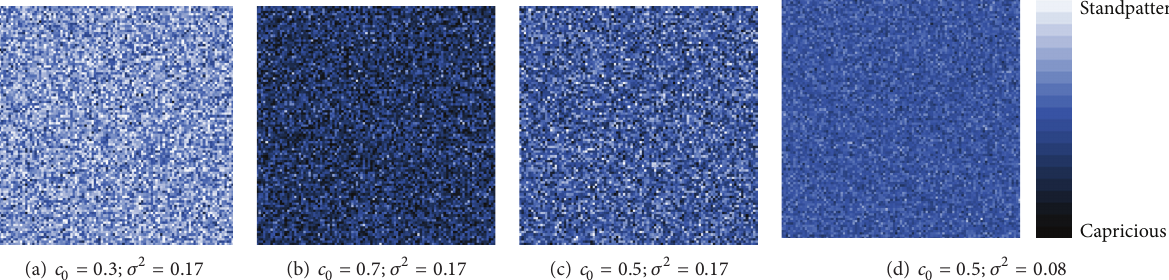
Figure 1: Influence of parameters in normal distribution on individual’s attitude; 0 ≤ 𝑐 ≤ 1 . Light color expresses individual is a standpatter (more inclined to keep its attitude). Dark color expresses individual is capricious (more inclined to change its attitude). The influence of mathematical expectation on individual’s initial conformity is shown in (a) and (b). The influence of variance on individual’s conformity is shown in (c) and (d).